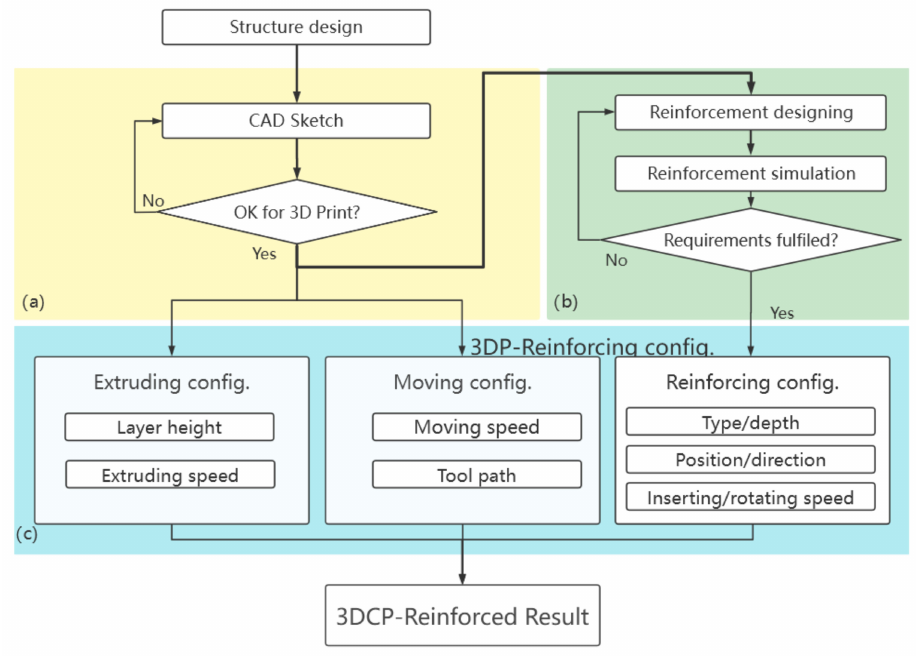
Figure 14. Flow chart of the 3DCP–Reinforcement manufacturing process: ( a ) CAD optimization for 3D printing, ( b ) reinforcement optimization, and ( c ) configurations of